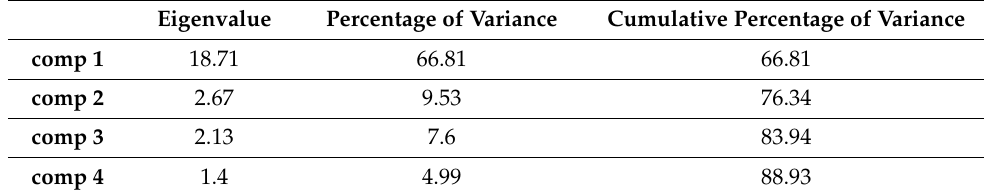
Table 2. Eigenvalues of the 4 first components.